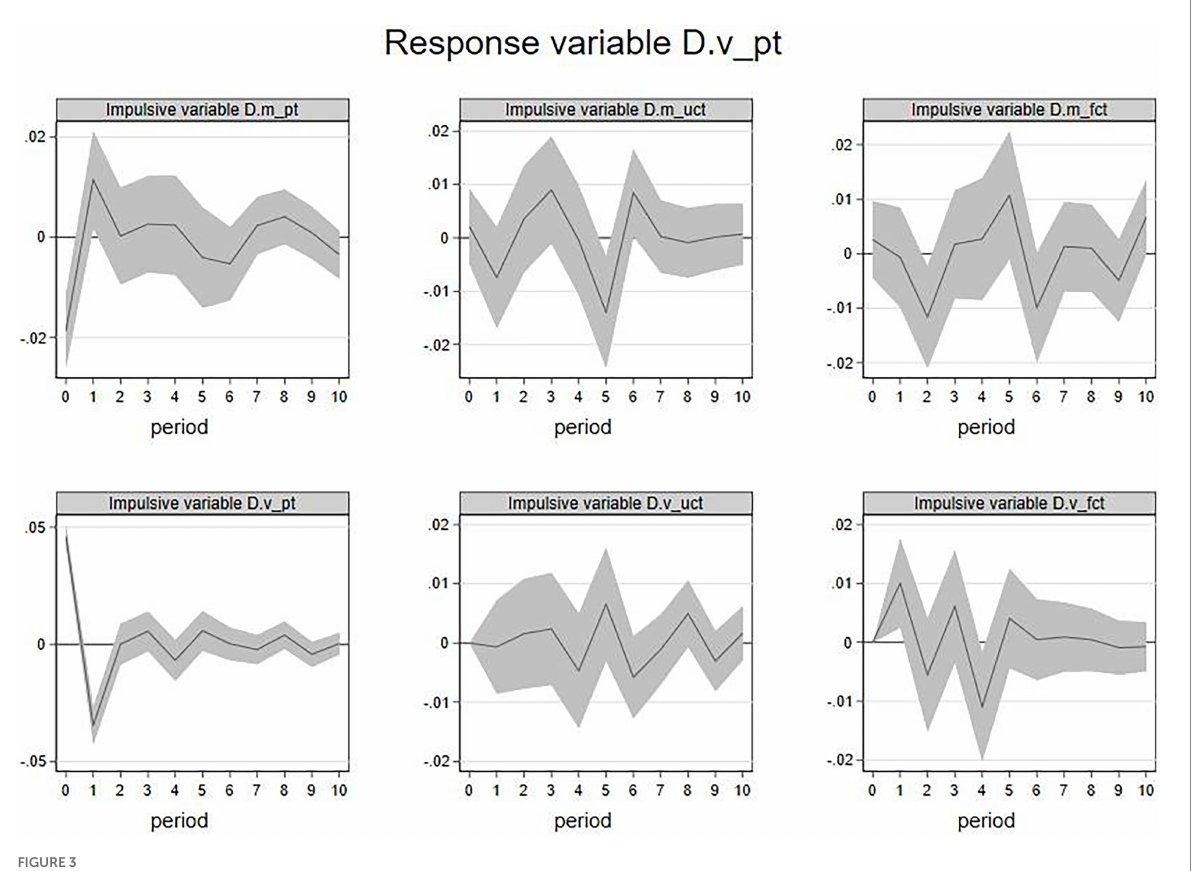
FIGURE 3 IRF: _ D.v pt (response